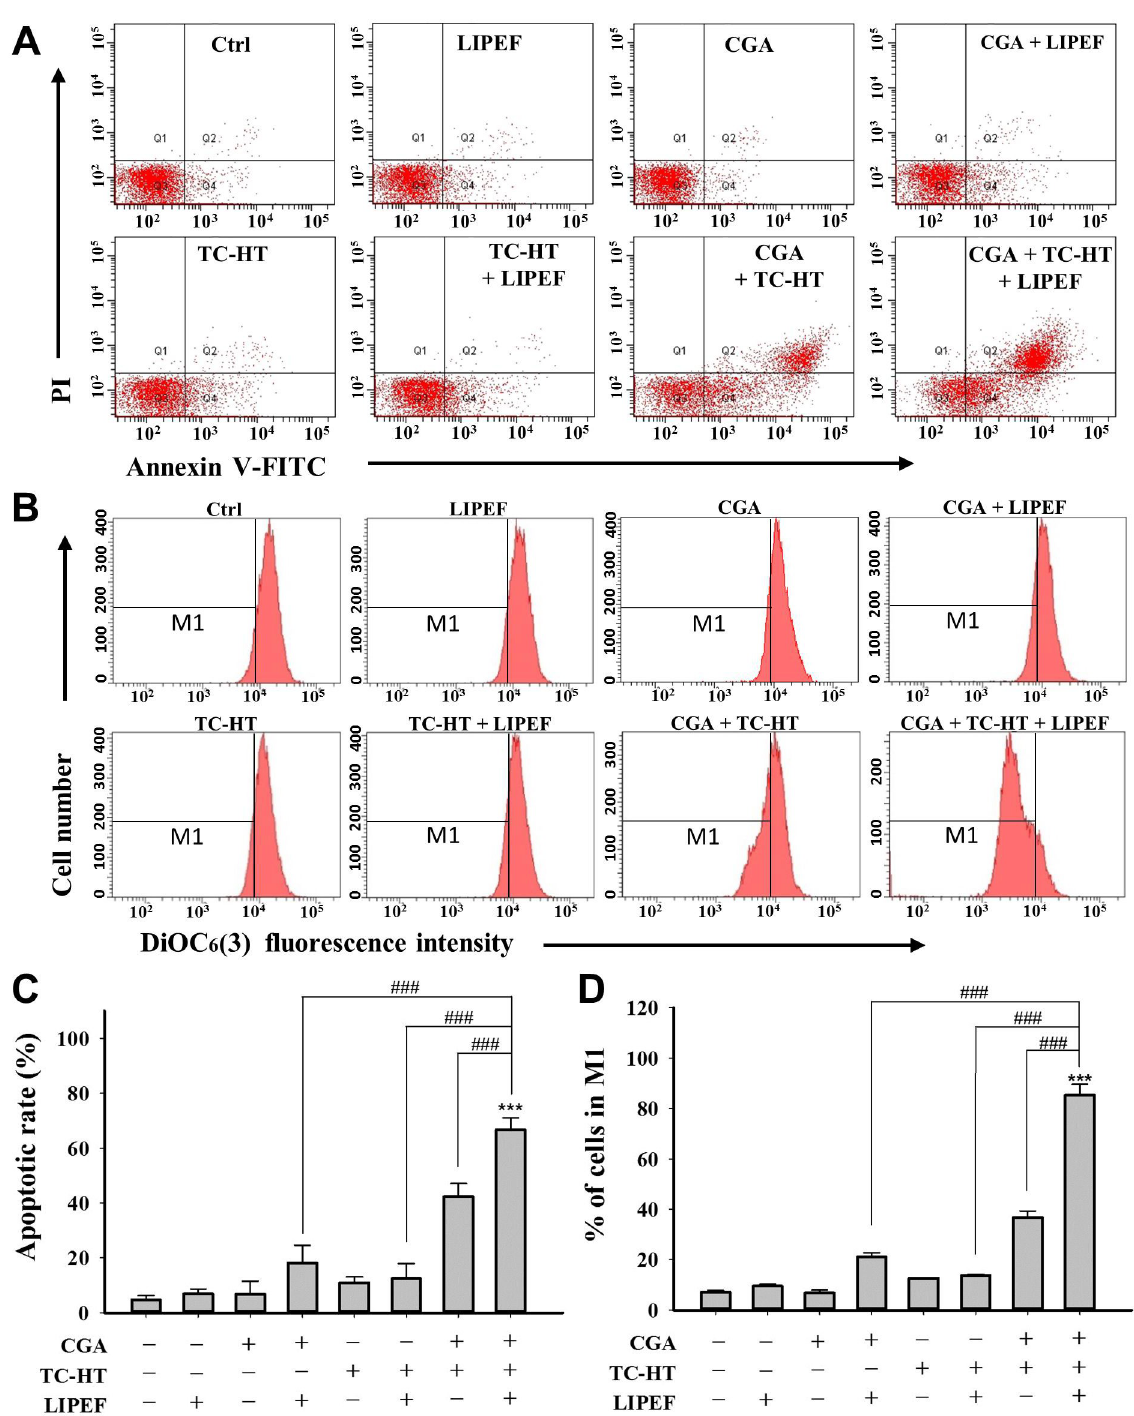
Fig 5. Triple combination of CGA, TC-HT, and LIPEF induces PANC-1 cells apoptosis through mitochondrial pathway. The apoptosis analysis for the PANC-1 cells following the treatment with CGA (200 μ M), TC-HT (10-cycles), and LIPEF (60 V/cm) alone, in double or triple combination for 24 h. (A) Flow cytometric detection of the apoptosis with Annexin V-FITC/PI double staining. (B) Flow cytometric analysis of MMP using DiOC 6 (3) staining. The M1 regions indicate the cells with the loss of MMP. (C) The percentage of Annexin V-FITC positive cells. (D) The percentage of cells in M1 region. Data are presented as mean ± S.D. in triplicate. ( ��� p < 0.001 vs. untreated control; ### p < 0.001 between indicated